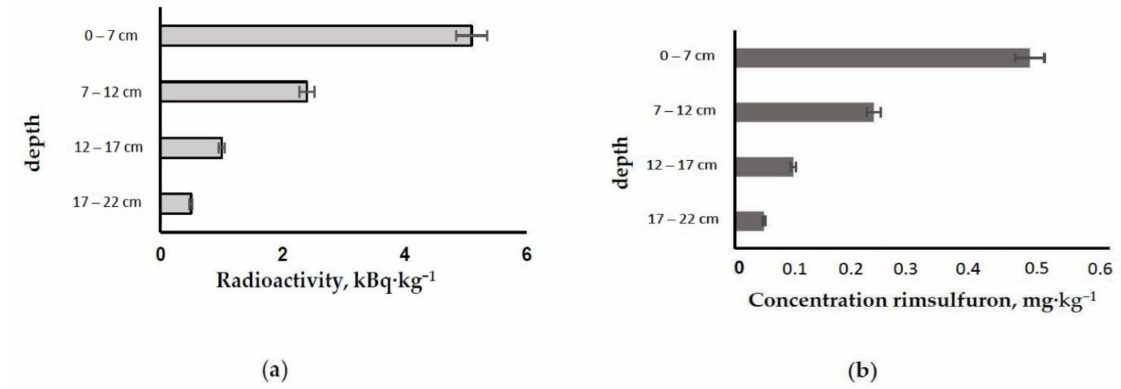
Figure 3. Distribution of 14 C isotope, kBq · kg − 1 ( a ) and pesticide ( b ) over the soil profile of the experimental system